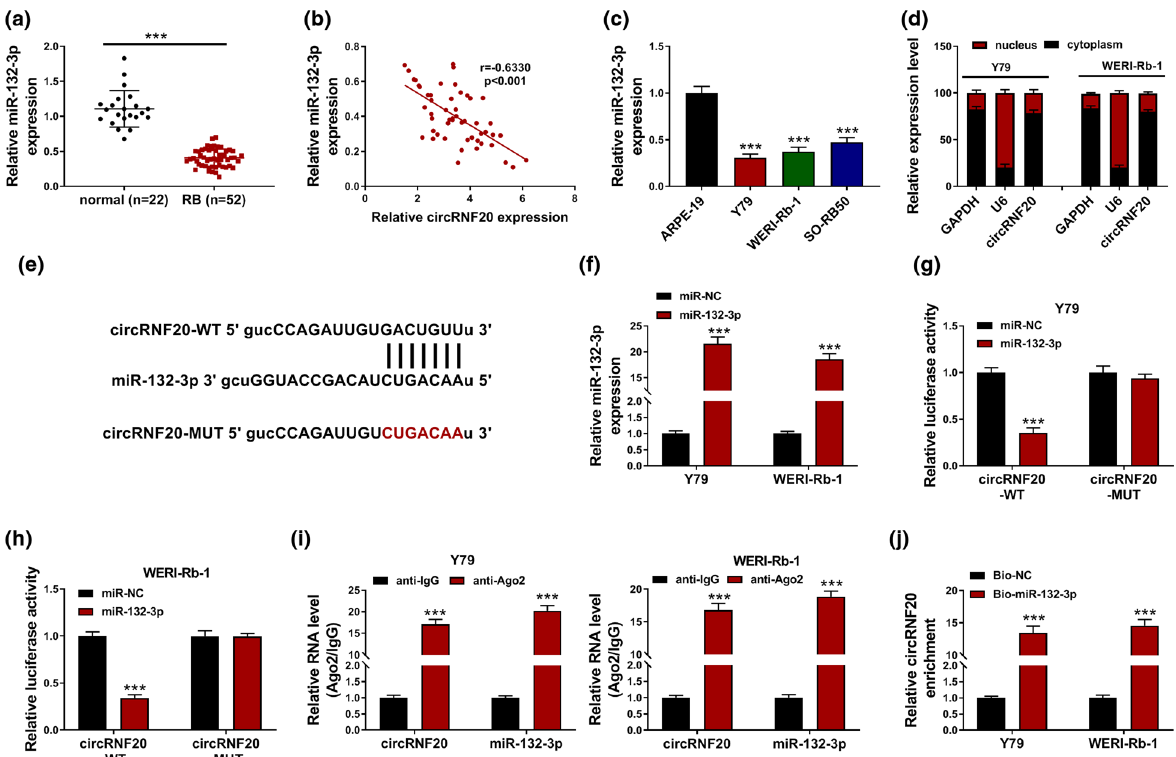
Figure 3: circRNF20 directly interacted with miR - 132 - 3p. ( a ) The expression of miR - 132 - 3p in RB tissues and normal tissues was detected by qRT - PCR. ( b ) The linear correlation between the levels of circRNF20 and miR - 132 - 3p in RB tissues was analyzed by Spearman ’ s correlation coe ffi cient analysis. ( c ) The expression of miR - 132 - 3p in ARPE - 19, Y79, WERI - Rb - 1 and SO - RB50 was detected by qRT - PCR. ( d ) The dis - tribution of circRNF20 in the cytoplasm and nucleus of Y79 and WERI - Rb - 1 cells was analyzed. ( e ) The binding sites between circRNF20 and miR - 132 - 3p were exhibited. ( f ) The expression of miR - 132 - 3p in Y79 and WERI - Rb - 1 cells with miR - 132 - 3p or miR - NC transfection was detected by qRT - PCR assay. ( g – j ) The relationship between circRNF20 and miR - 132 - 3p was investigated by dual - luciferase reporter assay, RIP assay and RNA pull - down assay. *** P <